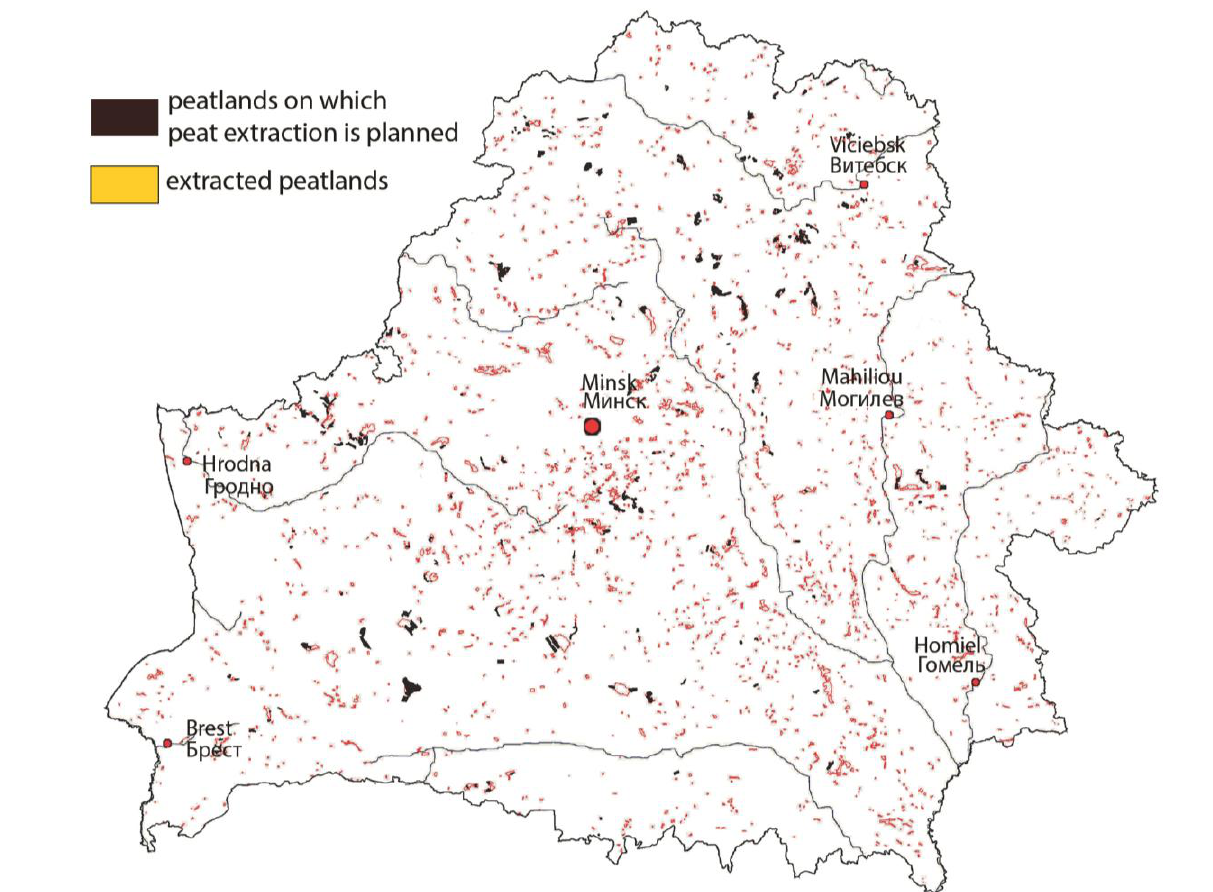
Figure 5. Map of Belarus showing the distributions of extracted peatlands and peatlands on which peat extraction is planned. Approximately 300,000 ha of mire have been drained for peat extraction (extracted peatlands) and 99,000 ha will be used for peat extraction before 2030. The total area of worked-out peatlands is 284,800 ha, of which 143,400 ha are subject to environmental